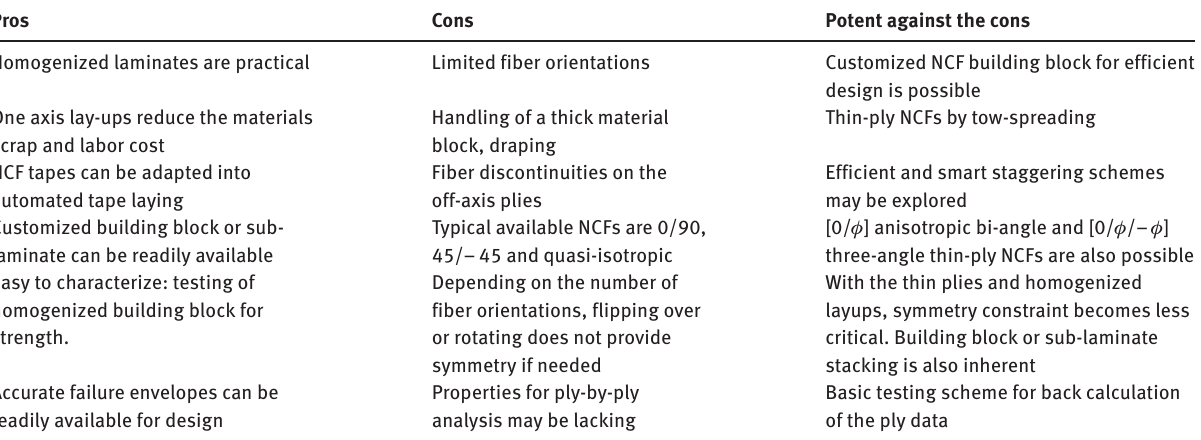
Table 1: Overview of pros and cons associated with the use of NCF building block and potential improvements by the thin-ply feature.